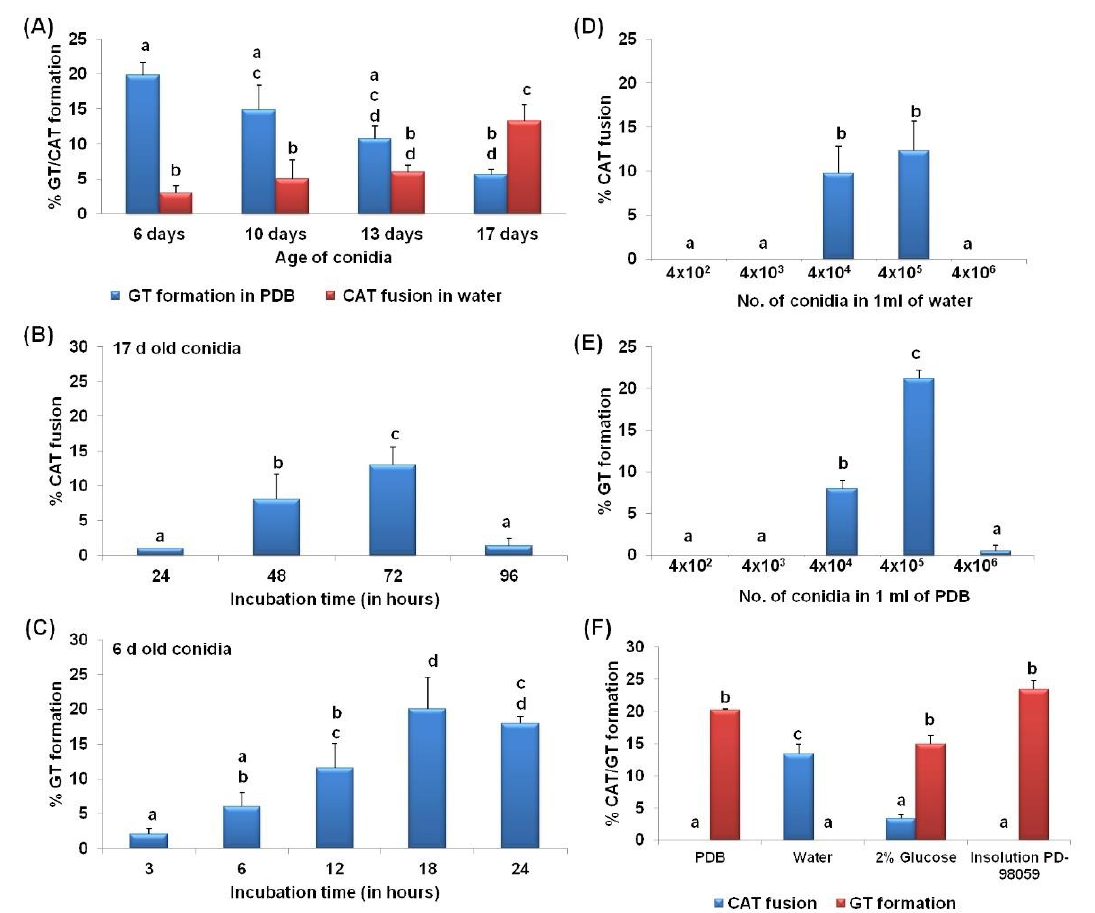
Figure 3. Germ tube formation and conidial anastomosis tube fusion dynamics in C. gloeosporioides . ( A ) Percentage GT/CAT formation in different aged conidia, viz., 6, 10, 13, and 17 days of C. gloeosporioides . ( B ) Percentage CAT fusion in 17 days old conidia of C. gloeosporioides incubated for different incubation times, viz., 24, 48, 72, and 96 h. ( C ) Percentage GT formation in 6 days old conidia of C. gloeosporioides incubated for different incubation times, viz., 3, 6, 12, 18, and 24 h. ( D ) Percentage CAT fusion in different conidial densities, viz., 4 × 10 2 , 4 × 10 3 , 4 × 10 4 , 4 × 10 5 , and 4 × 10 6 of 17-day-old conidia incubated in 1 mL of water. ( E ) Percentage GT formation in different conidial densities, viz., 4 × 10 2 , 4 × 10 3 , 4 × 10 4 , 4 × 10 5 , and 4 × 10 6 of 6-day-old conidia incubated in 1 mL of PDB. ( F ) CAT and GT formation percentage in PDB, water, glucose, and Insolution ™ PD98059 (inhibitor of MEK), CAT fusion induced in water supplemented with glucose and Insolution ™ PD98059; GT formation was assayed in PDB supplemented with glucose and Insolution ™ PD98059. GT/CAT formation was quantified as the percentage of conidia involved in GT/CAT formation. Average from three replicates ( n = 3), and 300 conidial numbers were counted per replicate. Bar indicates standard deviation. Statistical significance of differences was analyzed by one-way ANOVA with Tukey’s multiple comparison post-hoc test (bars with the same letter are not significantly different; p ≤